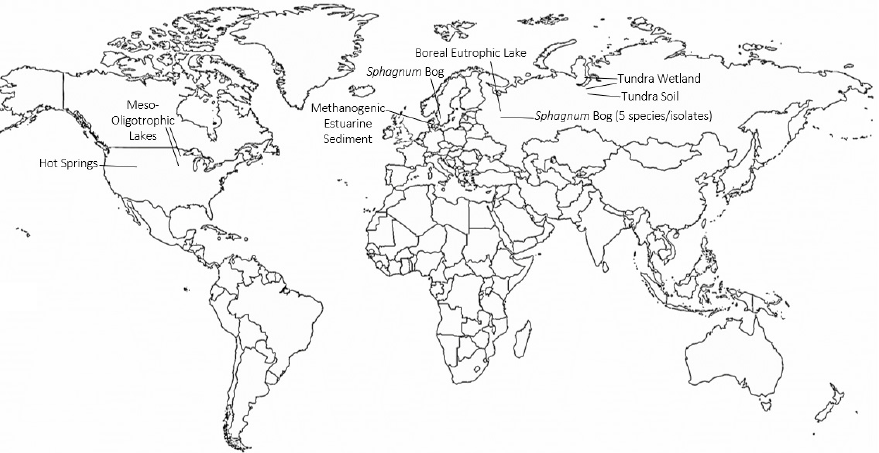
Figure 4. Global map showing locations and ecosystems where trimethylornithine lipids have been identified. Global map made with mapchart.net.